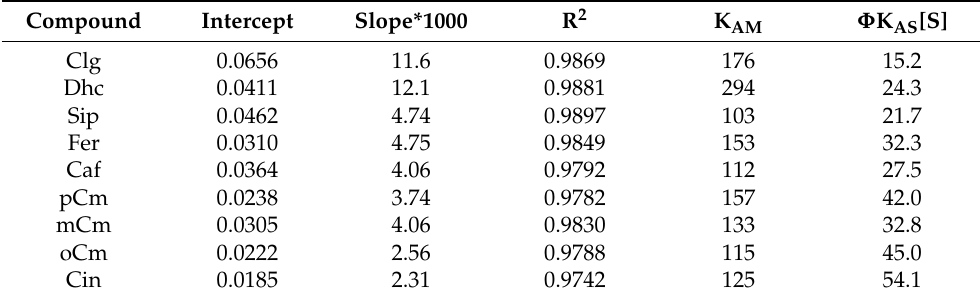
Table 5. Linear regression equations for 1/k vs. [Tween 40, mM] plots (Figure S4 data without 9.4 mM point) for HCAs and equilibrium constants (Equation (1) in above text).